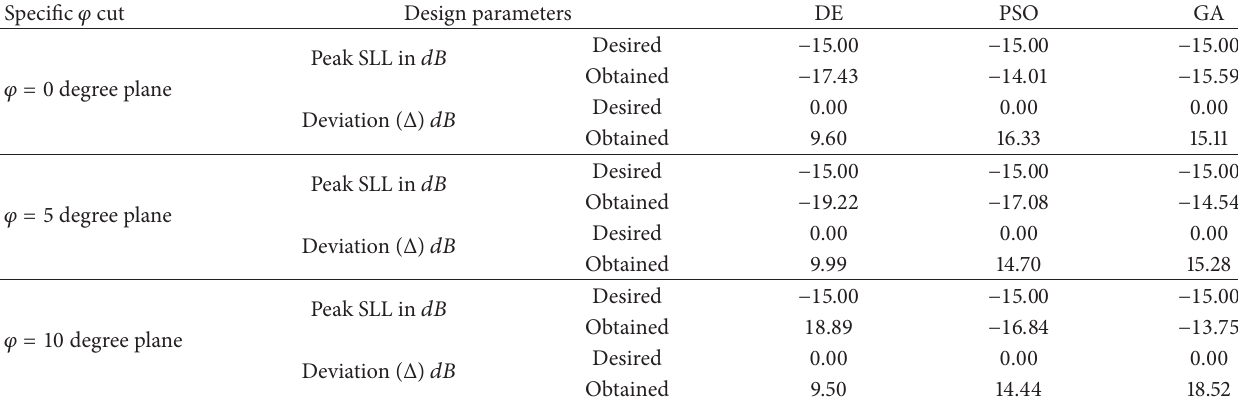
Table 1: Desired and obtained results for Case I of the design